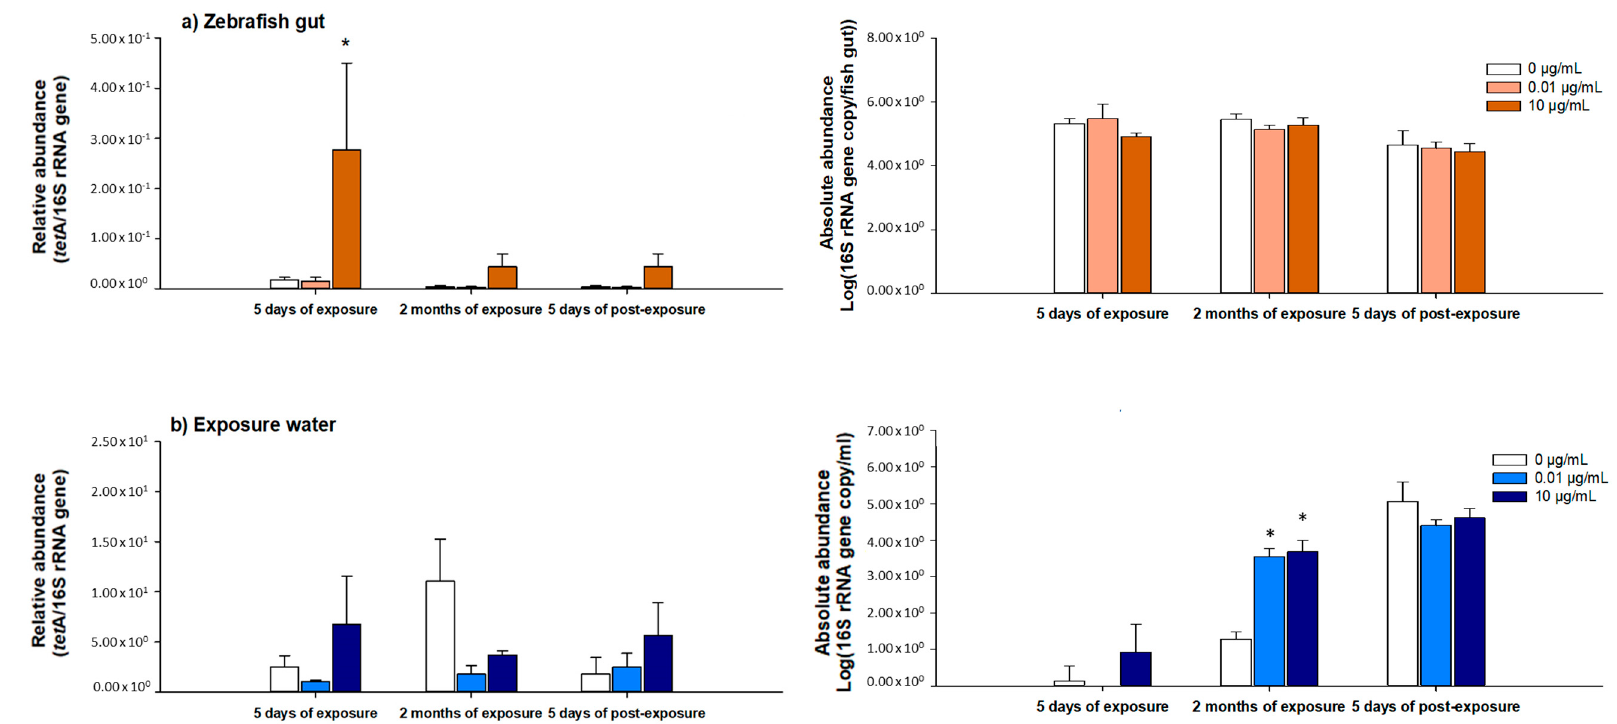
Figure 4. Relative abundance of tet (A) and absolute abundance of 16S rRNA gene (Log gene copy number/mL or fish gut), determined by qPCR in ( a ) zebrafish gut and ( b ) water exposed to OTC (0, 0.01 and 10 µg/mL) at three sampling times (5 days of exposure: 5 dE; 2 months of exposure: 2 mE; and 5 days postexposure: 5dPE). Asterisks (*) represent statistically significant differences ( p ≤ 0.05) towards the respective control (0 µg/mL).